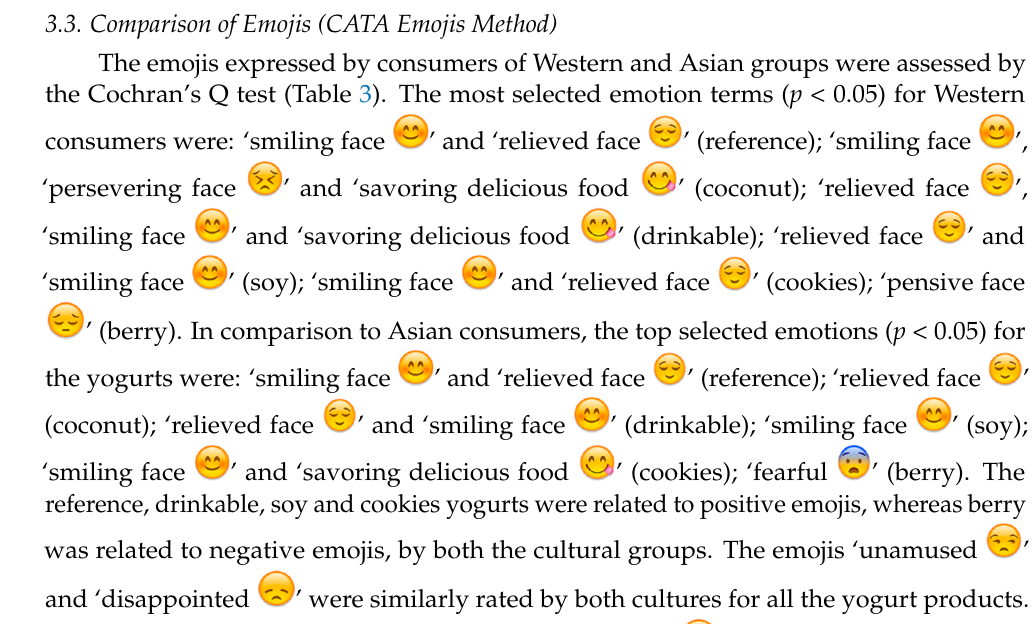
Table 3. Cochran’s Q test for emoji terms shown for the two cultural groups (Western consumers, Asian consumers) comparing terms within the culture, and using Fisher’s test to compare terms across cultures.